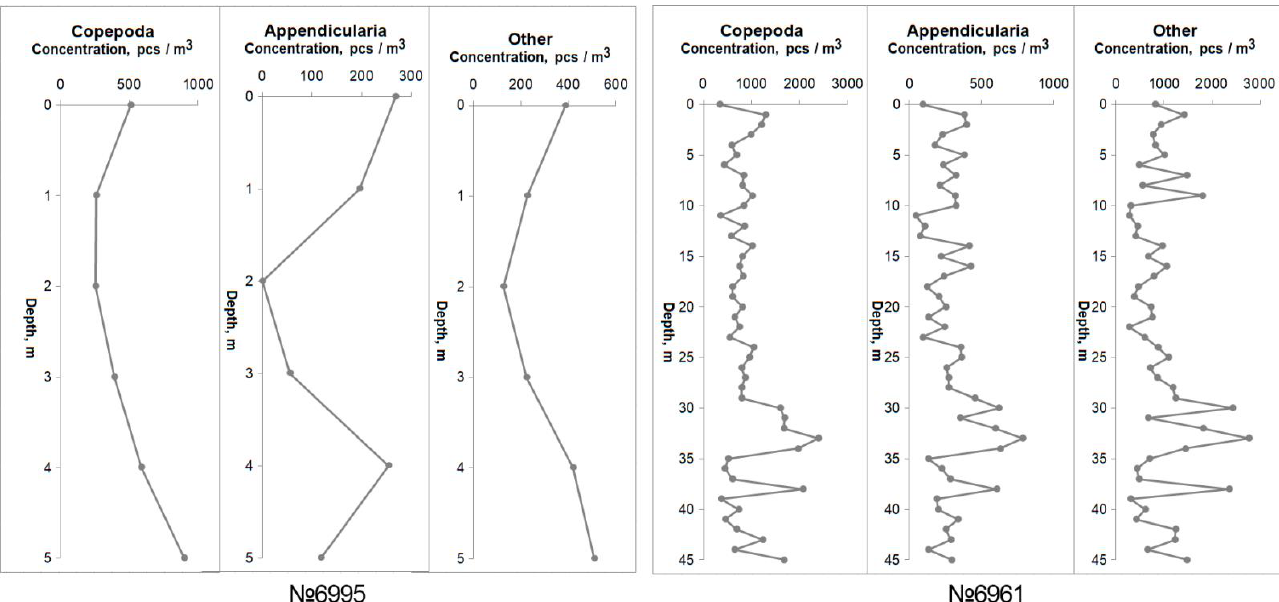
Figure 12. Results of automatic DHC classification of plankton at stations No. 6965 and No. 6961. Depth profiles of Copepoda , Appendicularia , and Others taxa concentrations are given.